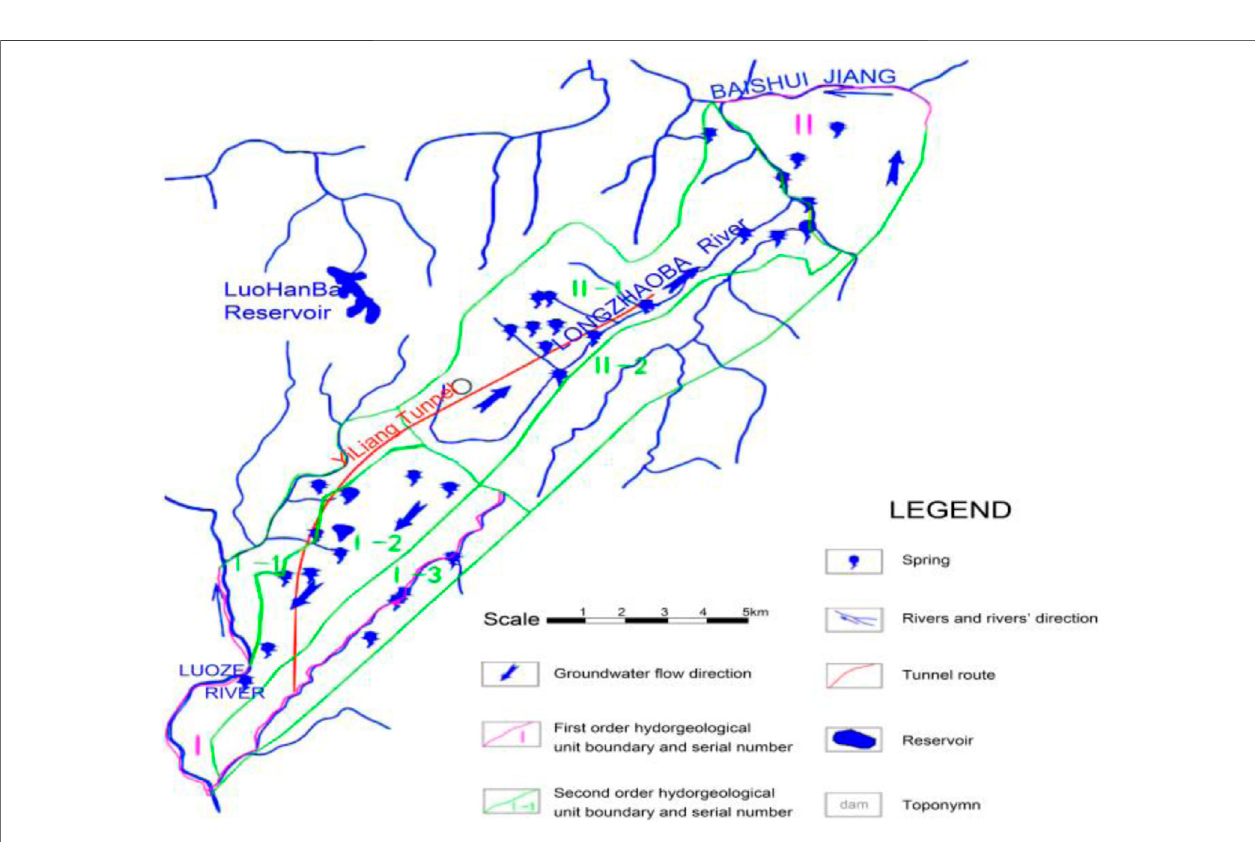
FIGURE 2 | Hydrogeological unit division map in the studying